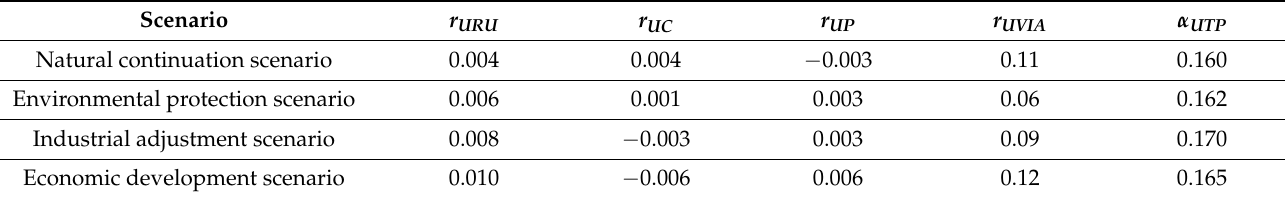
Table 6. Sensitive parameter values in the upper section.